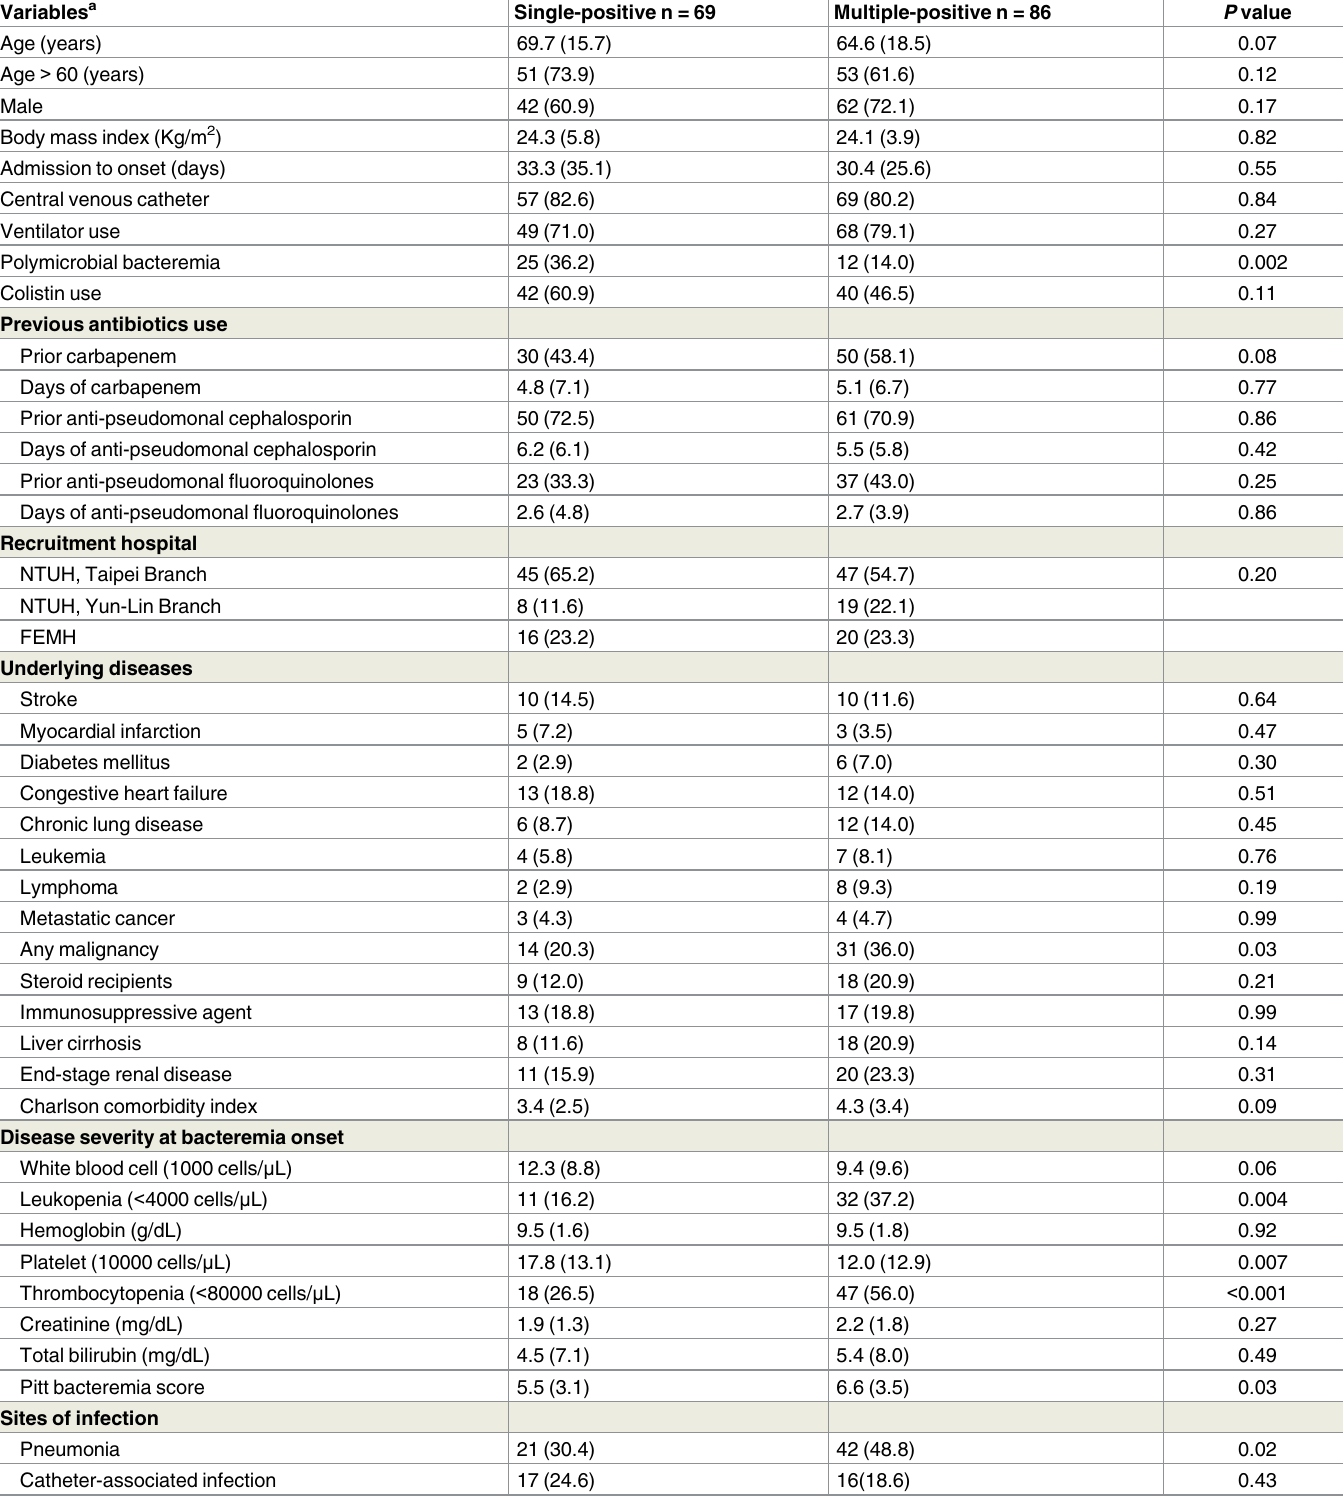
Table 1. Demographics and clinical characteristics of patients with either single- or multiple-positive blood cultures positive for A . baumannii